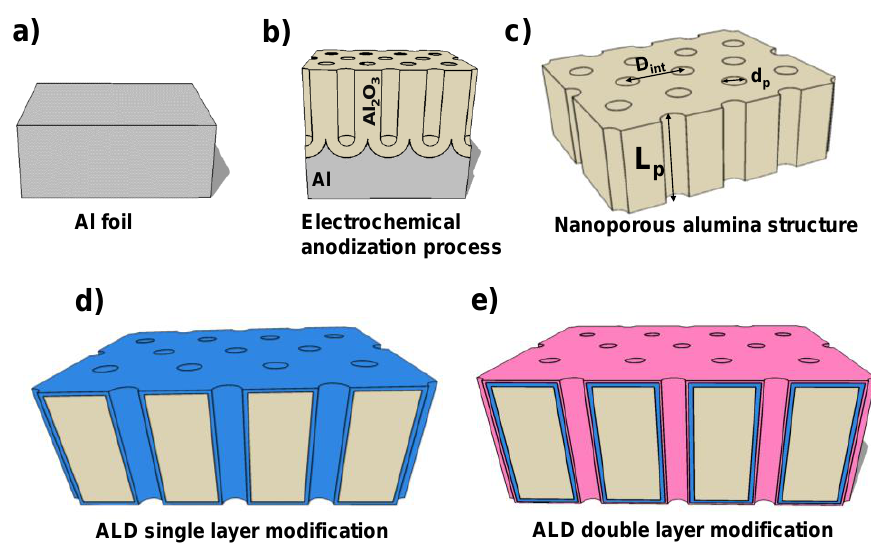
Figure 1. ( a – c ) Scheme of the NPAS fabrication and final structure; ( d ) nanoporous alumina-based structure (NPA-bS) after ideal single layer deposition; ( e ) NPA-bS after ideal double layer deposition.